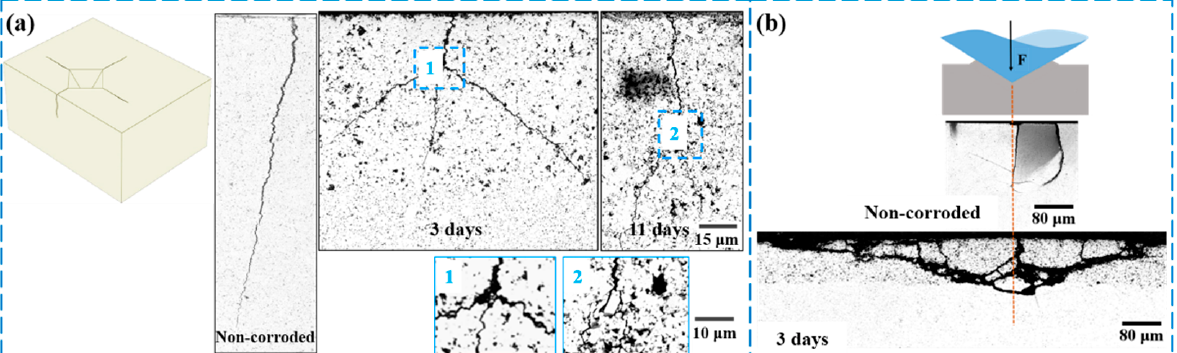
Figure 4. ( a ) Cross-section view of cracking phenomena resulting from pyramidal indentation under an applied load of 294 N for specimens previously exposed to corrosion media during different times, and ( b ) subsurface cracking scenario induced by scratching for non-corroded and corroded 6CoM samples (adapted from Ref. [44]).